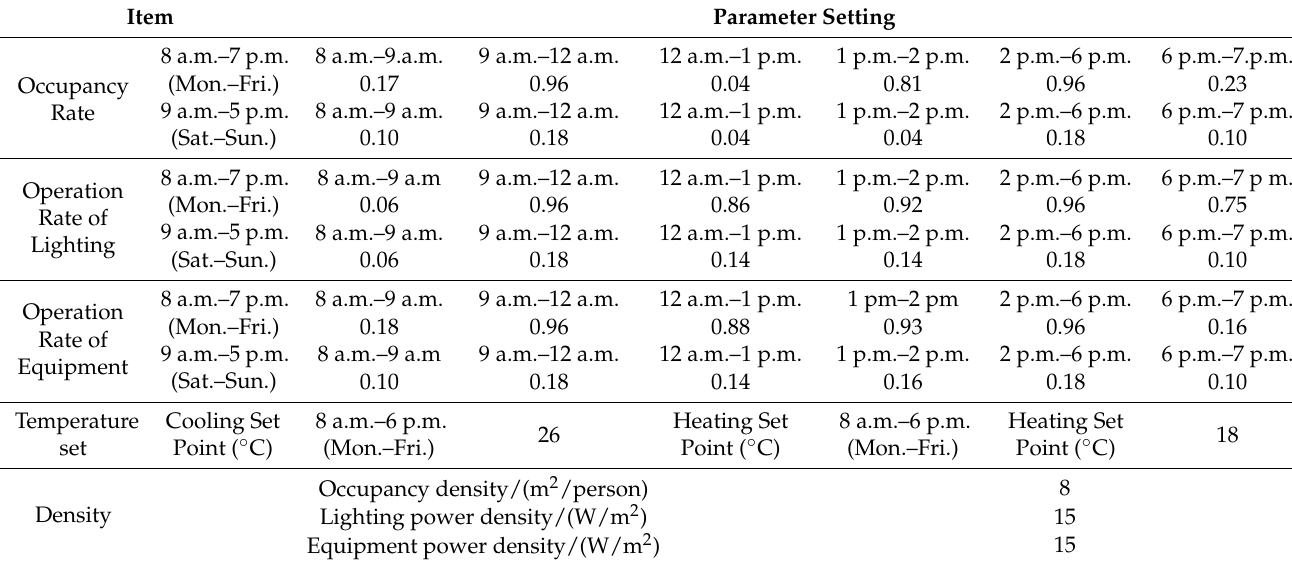
Table 2. Parameter setting in the BES model-1.